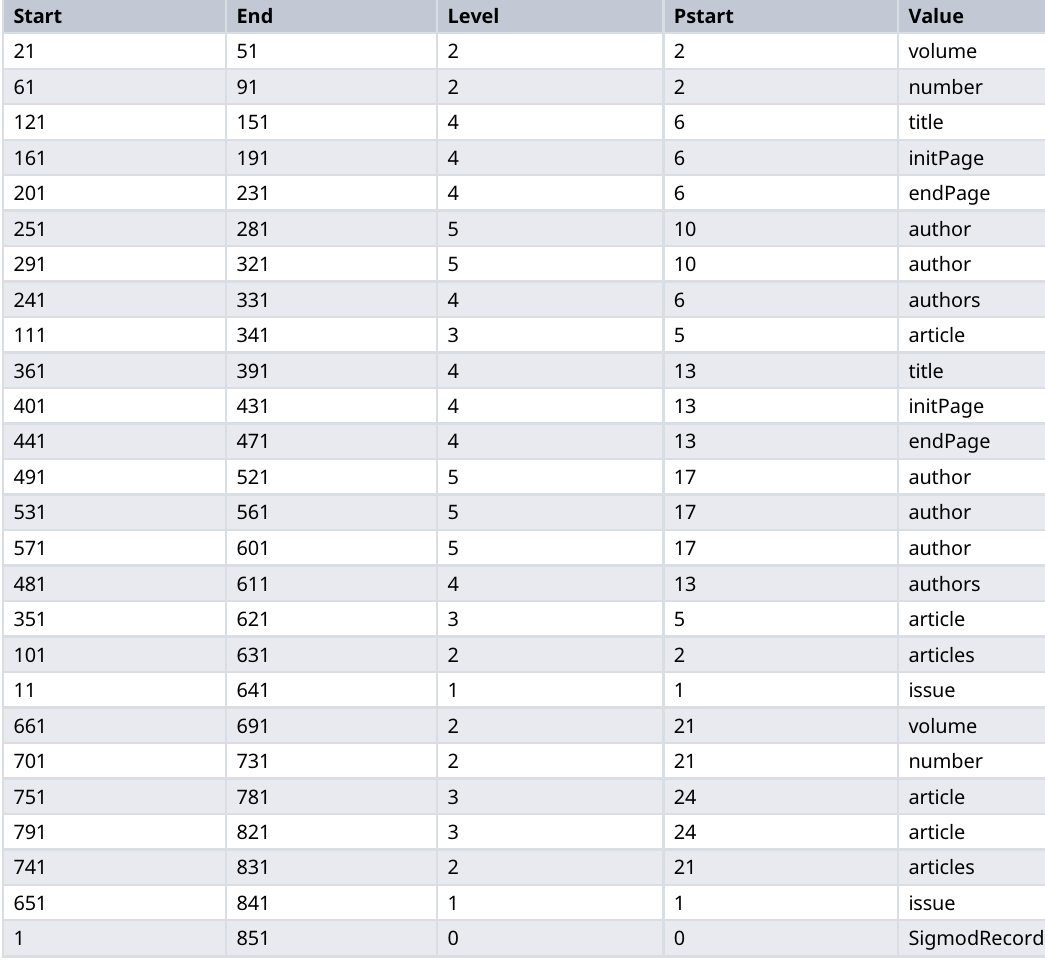
Table 1. iTable of Parent Table for initial labeling.